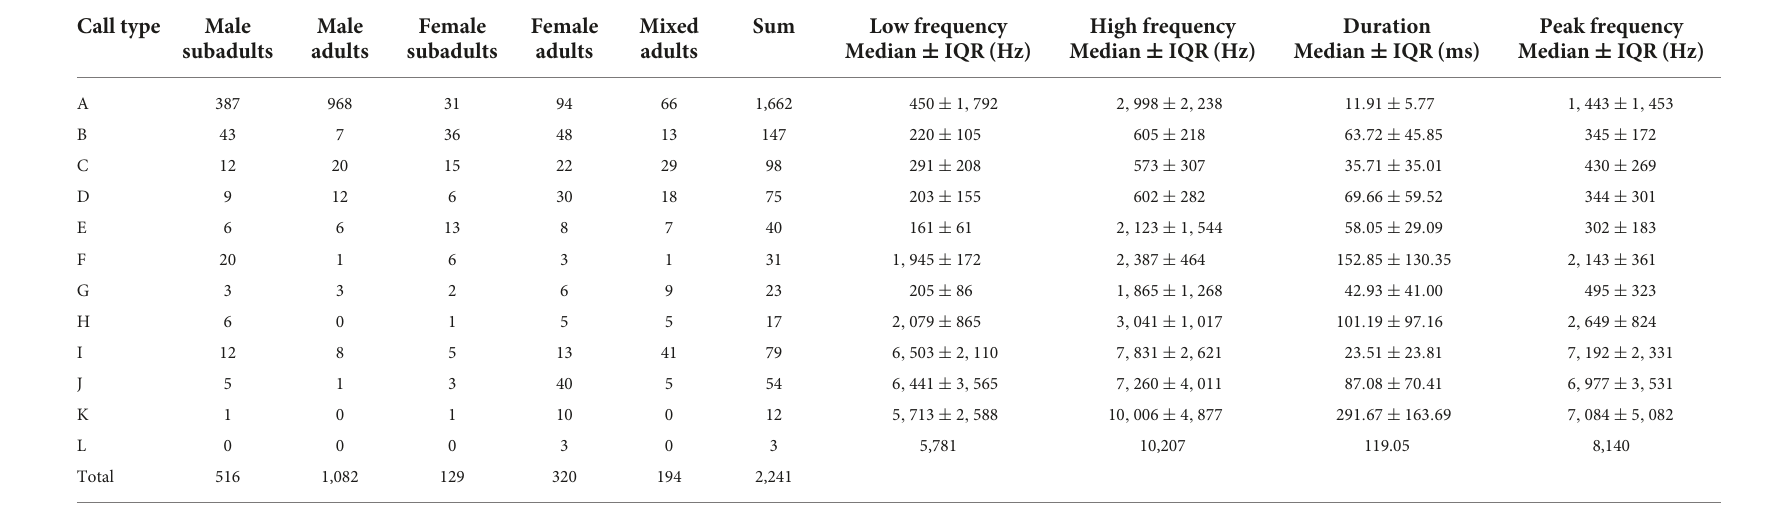
TABLE 1 Descriptive statistics of call types of Trachemys scripta elegans .